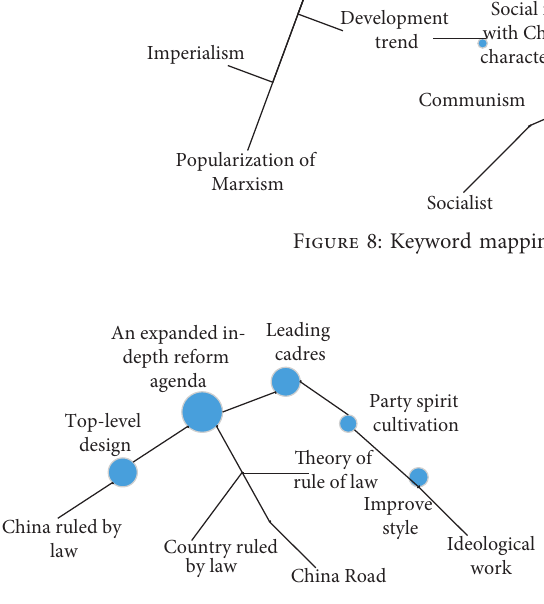
Figure 9: Keyword mapping of Marxist theory journals in 2014.